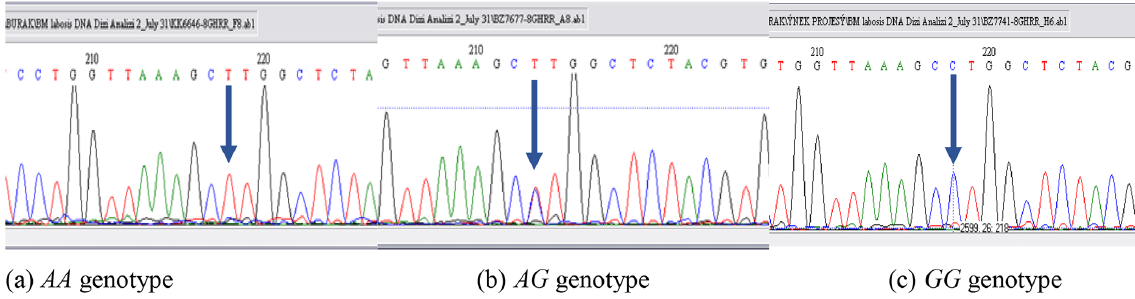
Figure 2. DNA sequence analyses (reverse sequences) for AA , AG , and GG genotypes for the GHR gene. Table 1. Variance analysis for milk yield and milk components according to genotype, parity, calving season and herd. Breeds Factors TDMY (kg/d) 305-DMY (kg) FC (%) ∗ FY (kg/d) PC (%) ∗ PY (kg/d) Jersey Genotype 0.117 0.152 0.008 0.682 0.002 0.263 Parity 0.013 0.001 0.349 0.069 0.028 0.037 Calving season 0.266 0.315 0.668 0.930 b − 0 . 009 0.002 p < 0.001 0.001 0.158 Holstein Genotype 0.004 0.004